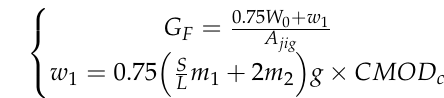
Figure 11. Impact of PF and RTA on the flexural